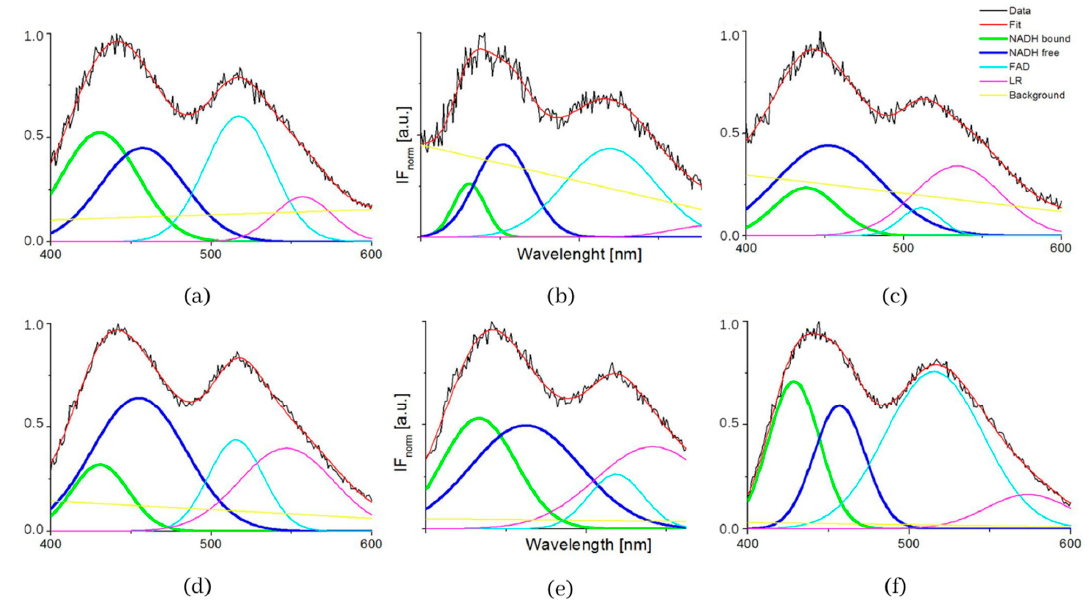
Table 3. The ratios of areas under calculated Gauss curves of free and bound NADH, AF/AB, at pH 5, 7 and 8 in deconvoluted spectra of healthy cells 3T3 and carcinoma cells CT26.